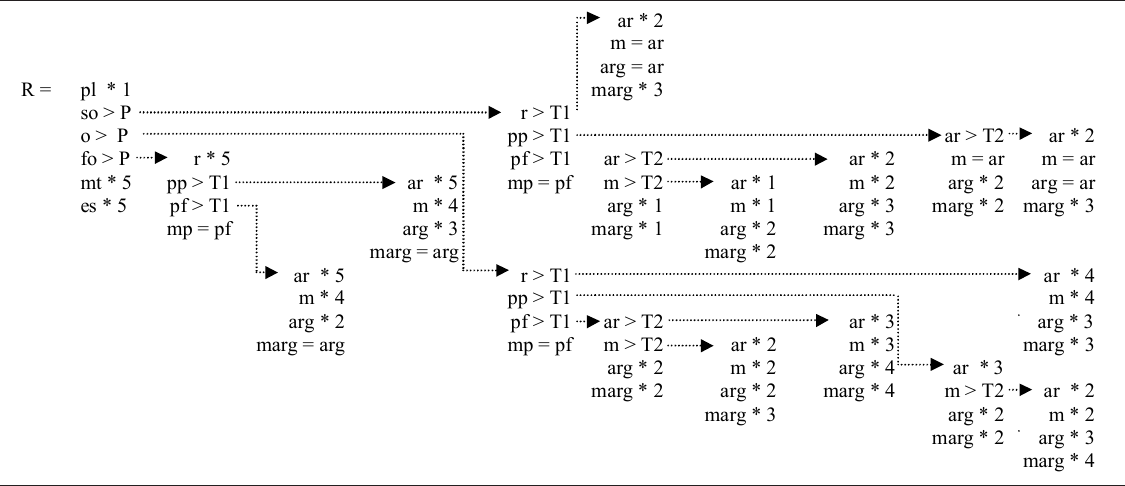
Figura 4. Representação esquemática da árvore de decisão utilizada na avaliação da soja, considerando o requerimento de uso da terra risco de erosão. Em que: R - relevo; P - profundidade do solo; T1 - textura superficial; T2 - textura subsuperficial; pl - plano; so - suave ondulado; o - ondulado; fo - forte ondulado; mt - montanhoso; es -escarpado; r - raso; pp - pouco profundo; pf - profundo; mp - muito profundo; ar - arenosa; m - média; arg - argilosa; marg - muito argilosa; *1 - limitação nula ou ligeira; *2 - limitação moderada; *3 - limitação forte; *4 - limitação muito forte.